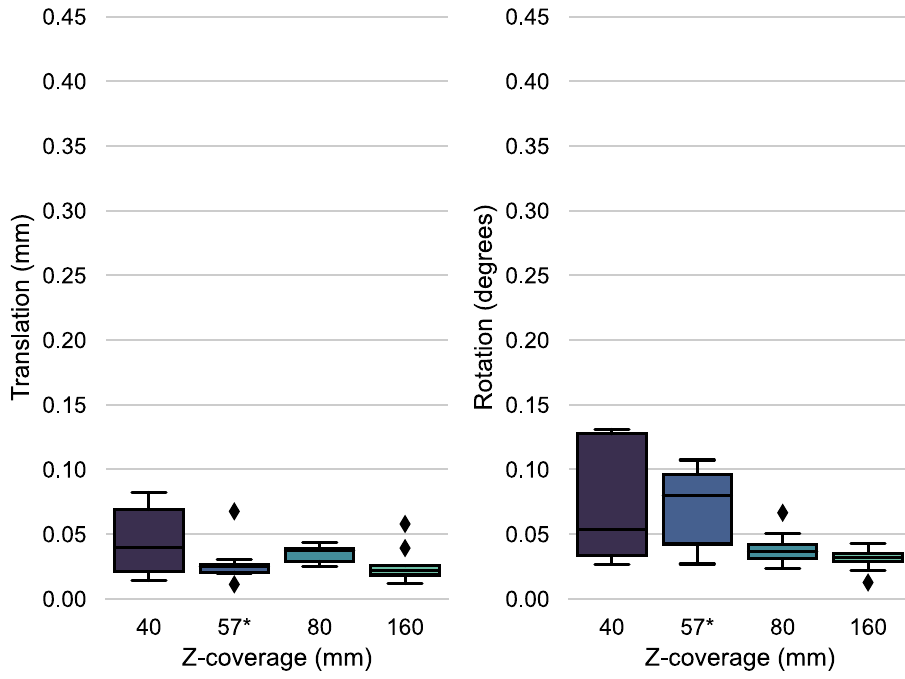
Figure 5. Z-coverage induced error: The error in registration at different levels of Z-coverage. The translational error in mm is shown in the left subgraph, while the rotational error in degrees is given in the right subgraph. Imaging technique: serial spiral 3D-CT. *= Z-coverage of scanner used in this